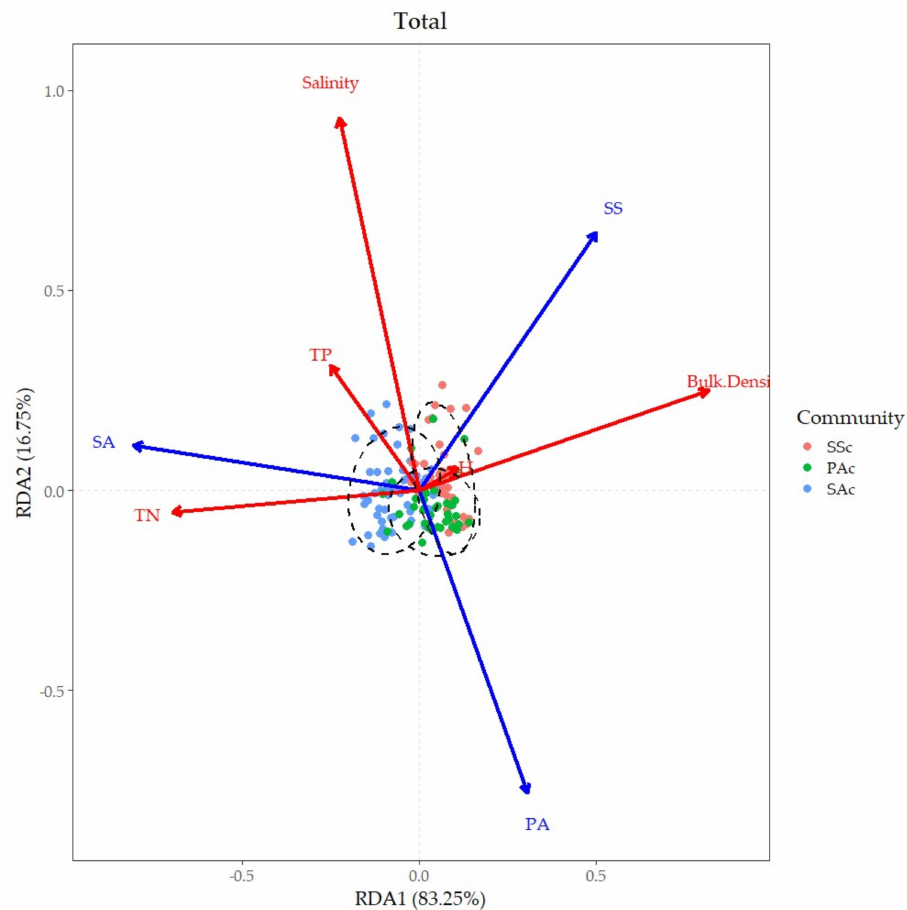
Figure 4. A two-dimensional graph of RDA ordination for communities and soil factors. The cumulative interpretation rates of the two sorting axes are labeled on the axis labels. Different colors represent different communities. The red axes represent the soil factors. The blue axes represent the species. The solid dots represent the soil factors corresponding to the communities.